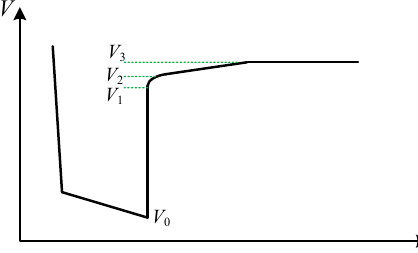
Figure 6. Terminal voltage response curve at the end of battery discharge.